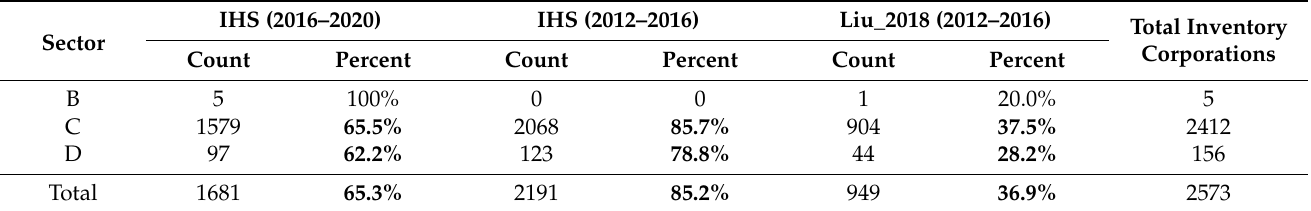
Table 3. Comparison of cross-validated corporations and their compositions